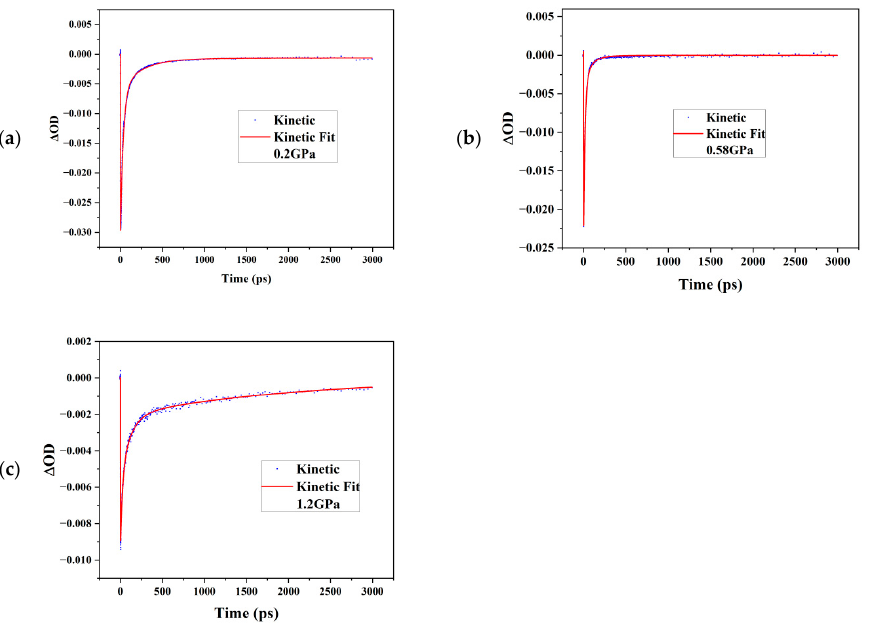
Figure 8. ( a – c ) are dynamic traces extracted from the transient absorption spectra of Mn-doped CsPbBr 3 under 0.2 GPa, 0.58 GPa and 1.2 GPa by global fitting. τ 2 belongs to the scattering process of optical phonons and acoustic phonons [51].